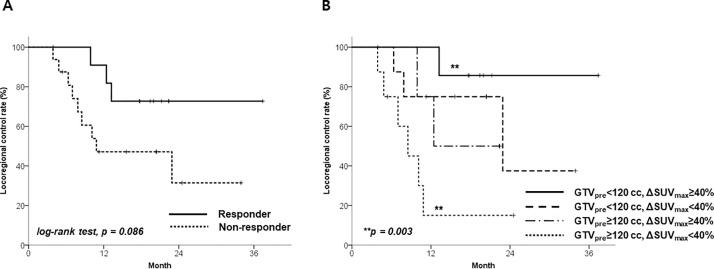
Locoregional control rate according to the SUVmax change: A—according to the SUVmax reduction rate, and B—stratified by pretreatment GTV (GTVpre).Responders were patients with SUVmax reduction rates ≥40%, whereas non-responders were those with SUVmax reduction rates <40%.